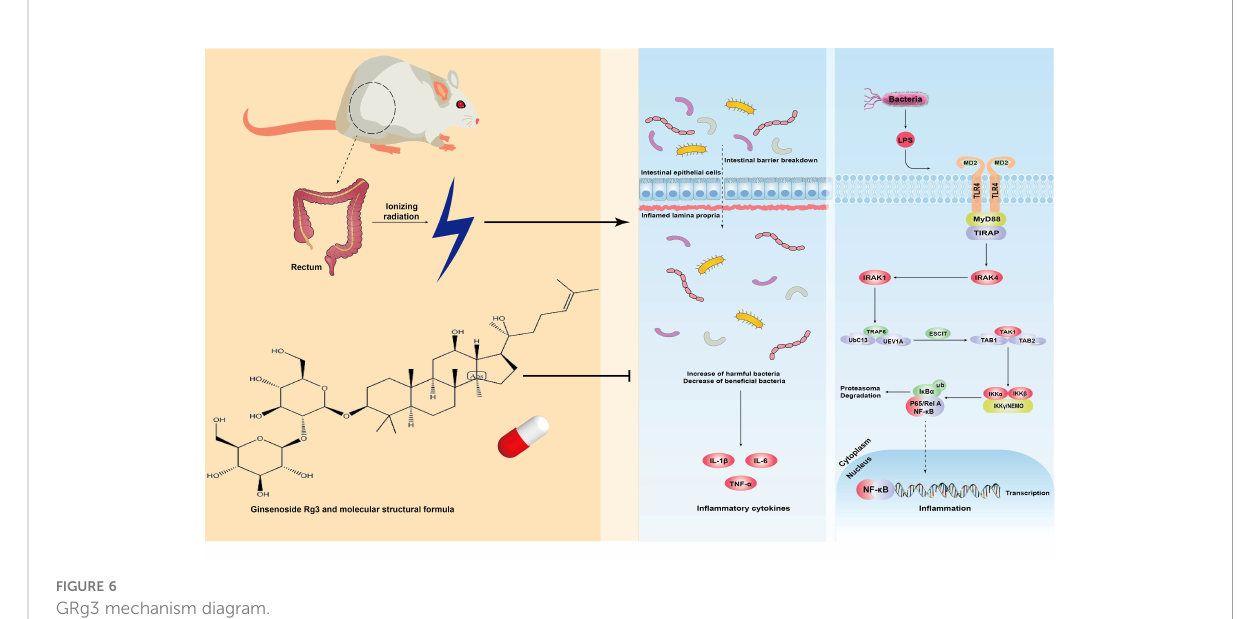
FIGURE 6 GRg3 mechanism